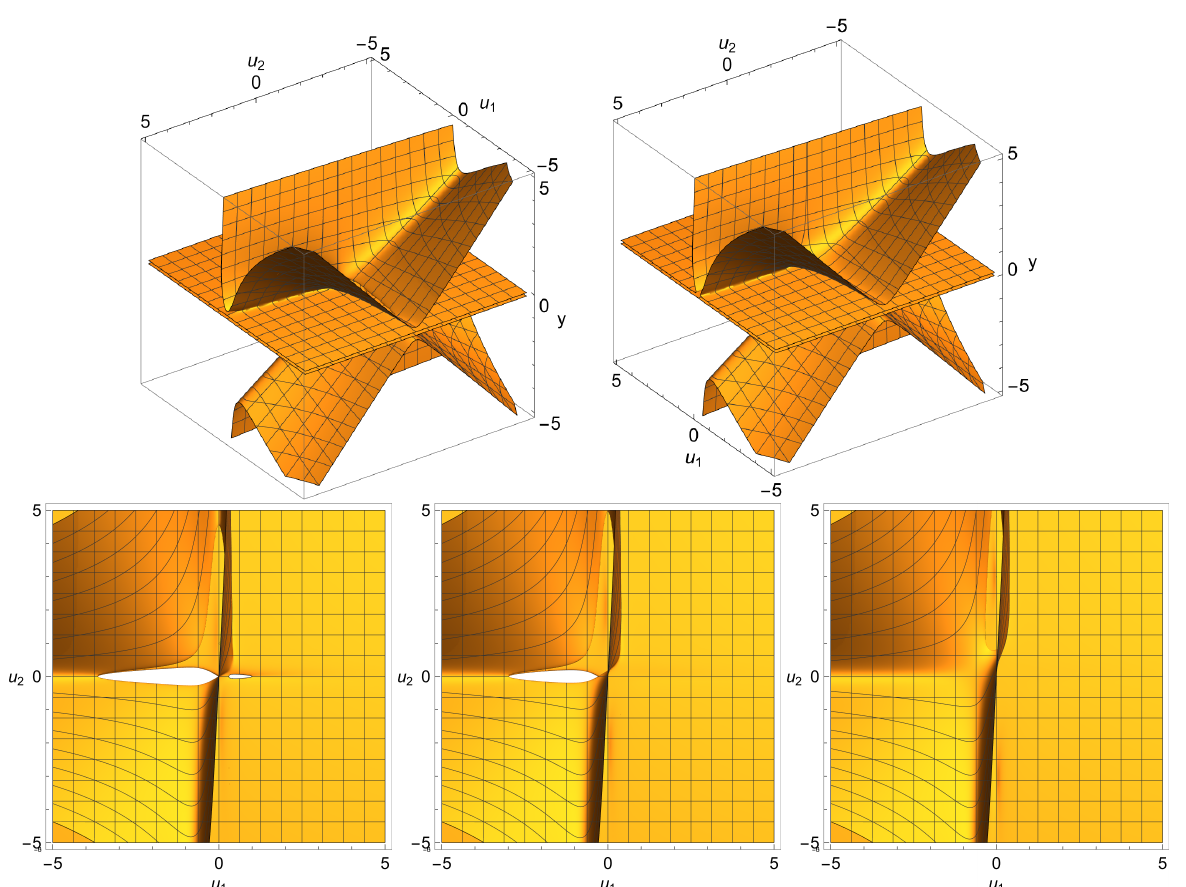
( 2 ) ( t ) from the u (cid:0) (cid:1) = 1, to the ε ( r ) = ε ( i ) = 0.01 and frequency Ω − 0 = 3. 0